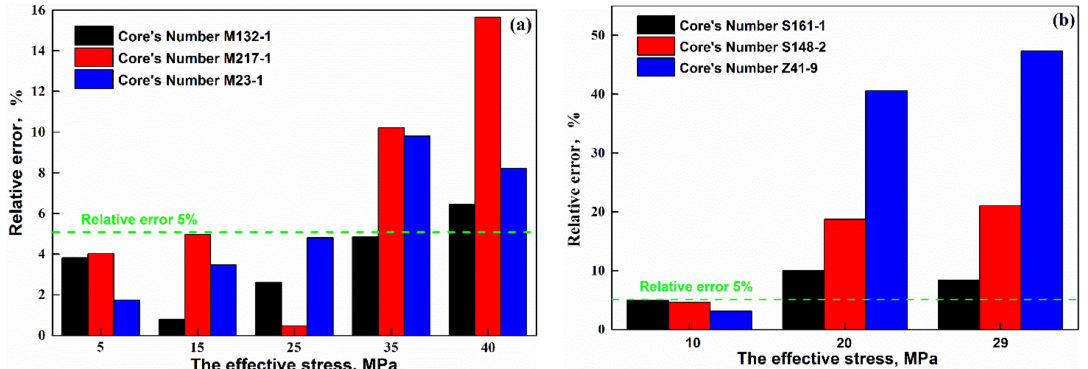
Figure 3. The relative errors of the permeability calculated by the proposed model and that found in experiments under various effective stress conditions; (( a ) the relative error when compared with the experimental data published by Zhong et al. [49]; ( b ) The relative error when compared with the experimental data published by Liu et al.